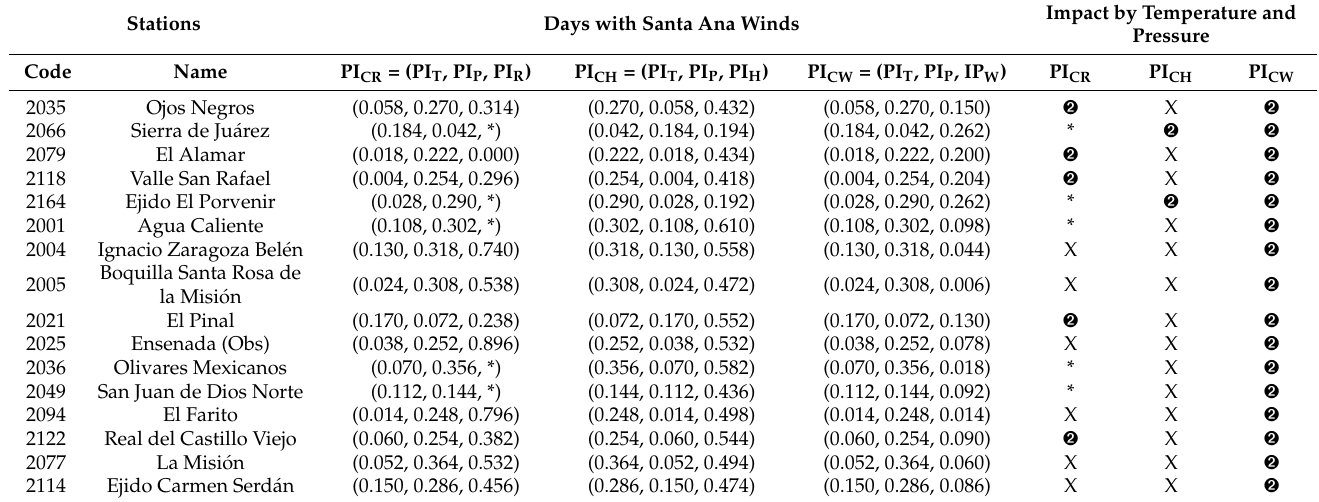
Table 5. Climate predictability index for days with Santa Ana winds and correlation between meteorological